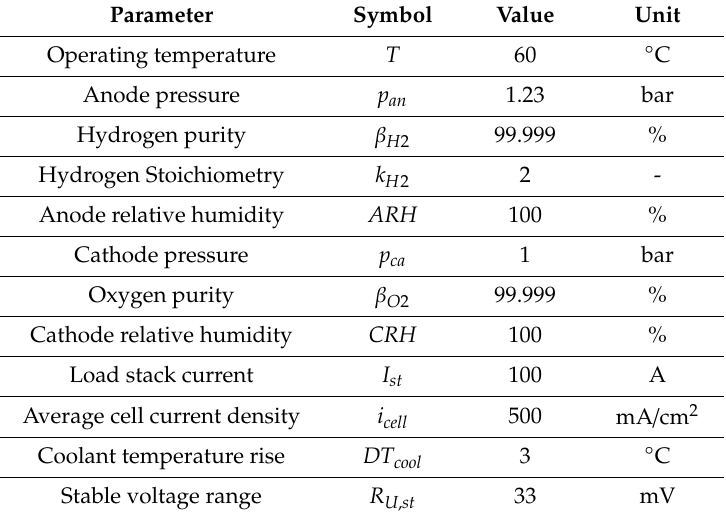
Table 8. Assumed operating conditions of the NedStack P8.0-68 PEM fuel cell stack.